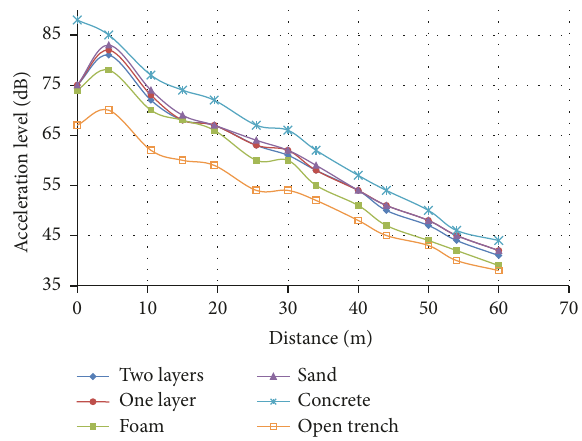
Figure 10: The relationship between the acceleration level and distance under case 5